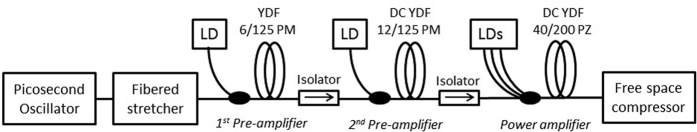
Schematic diagram of the high power picosecond pulsed laser, where LD and DC YDF denote a laser diode and a double clad Ytterbium doped fiber, respectively.